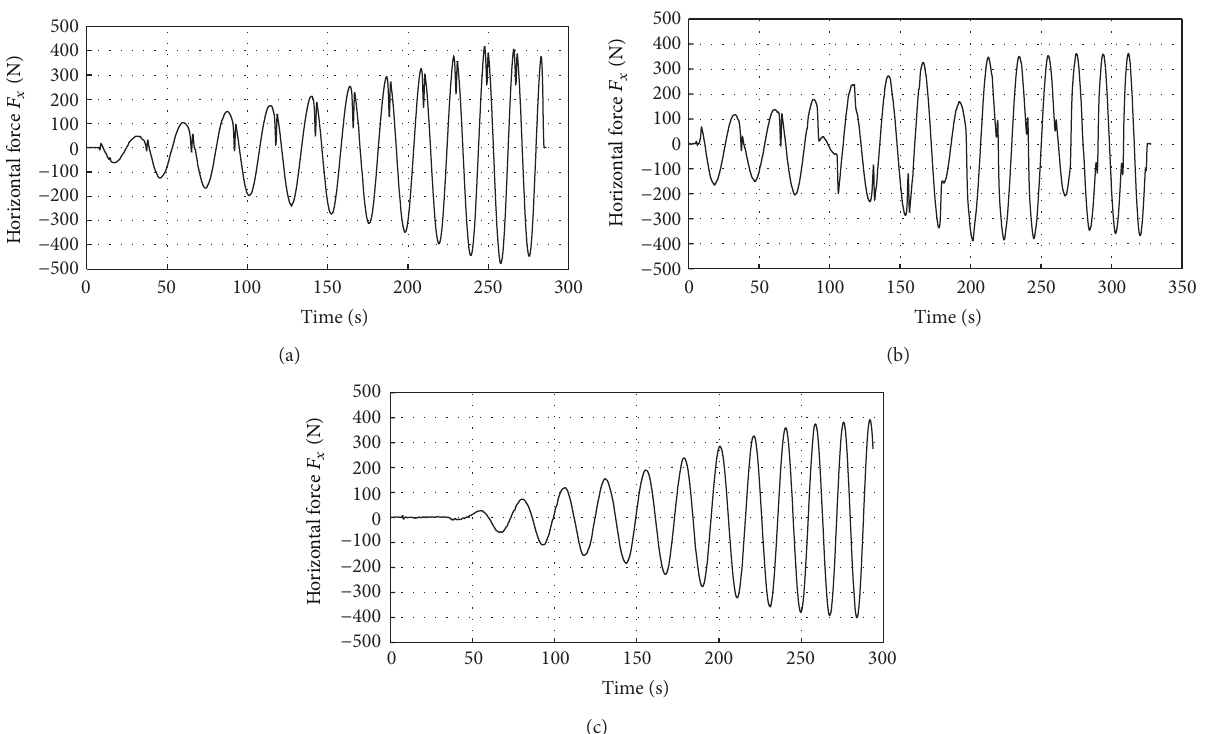
Figure 7: The horizontal force ( 𝐹 𝑥 ) variation for the specified three different trajectories.